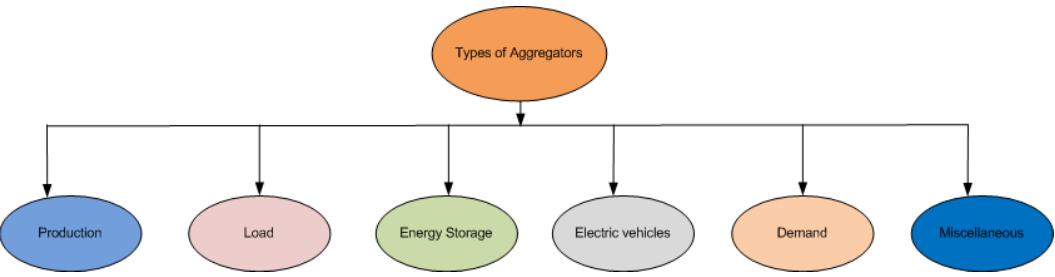
Figure 3. Types of aggregators depending on the source of aggregated